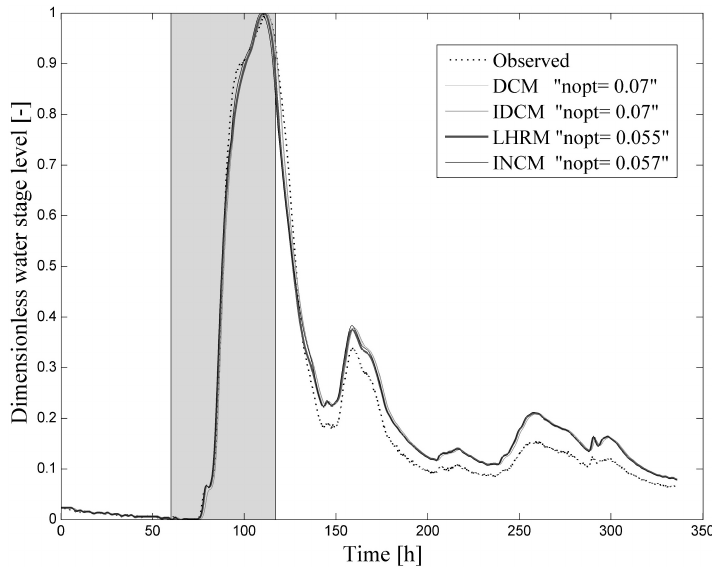
Figure 7. Observed and simulated stage hydrographs at the Hunsdorf gauged site in the event of January 2011.